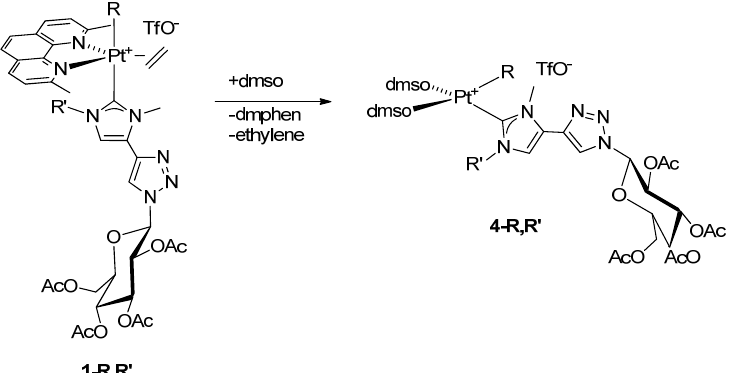
Scheme 3. Reactivity of 1-R,R’ complexes in DMSO-d 6